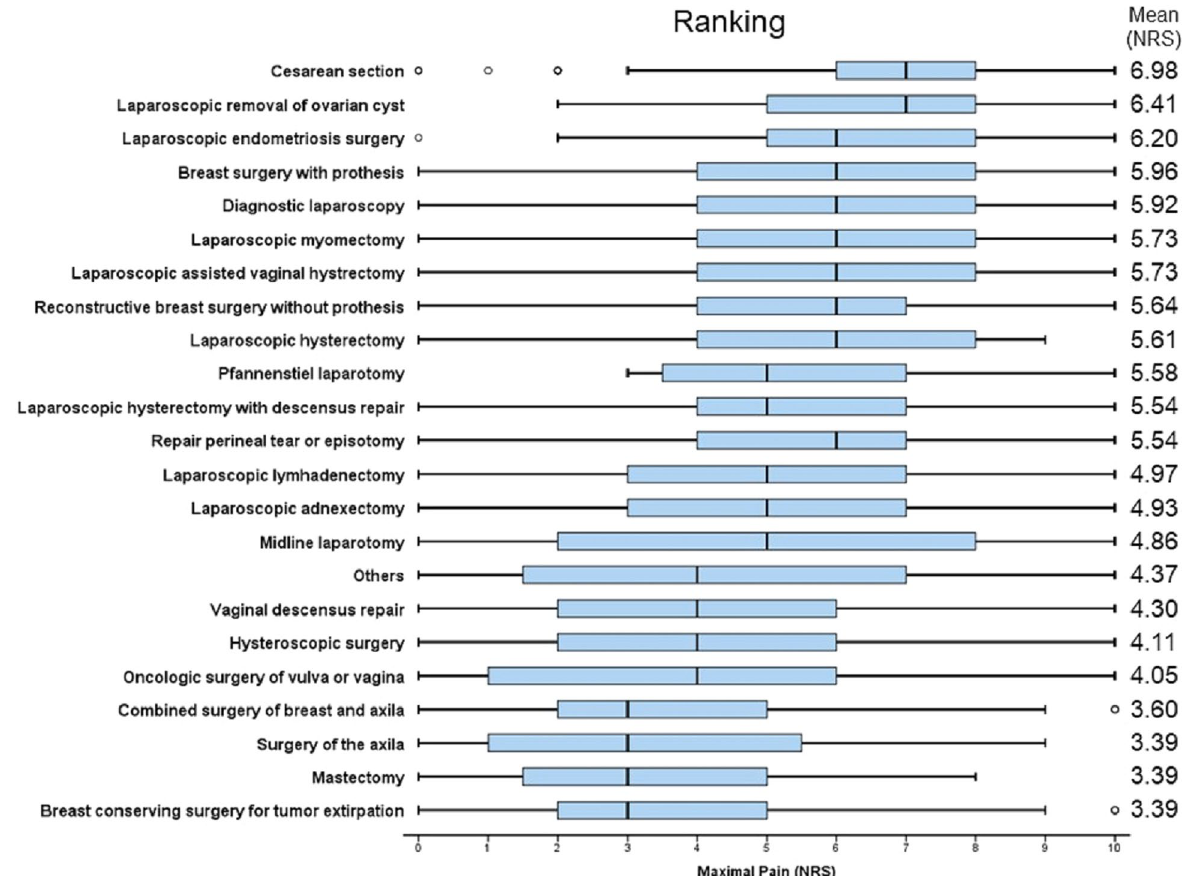
Figure 2. Ranking of postoperative pain depending on type of surgery. Postoperative pain scores 24-32 h after surgical procedures. Horizontal box plots indicate worst pain since surgery on 11-point numeric rating scale (NRS). Box edges indicate 25th and 75th percentiles. Whiskers indicate 5th and 95th percentiles. Procedures ranked in descending order of median pain severity. Mean scores (also shown) were used to rank surgical groups with identical median NRS scores. NRS scores were adjusted for age, surgical approach, use of innovative pain strategies, chronic pain patient and time of beginning of surgery using the regression